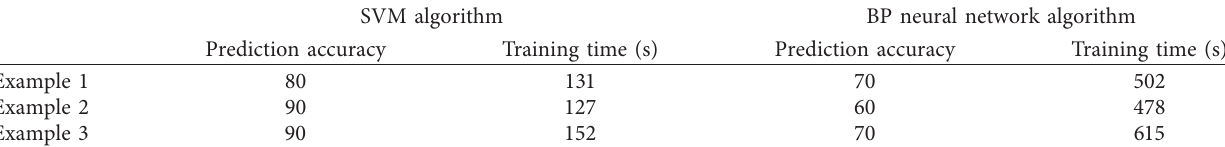
Table 7: Algorithm effect comparison.